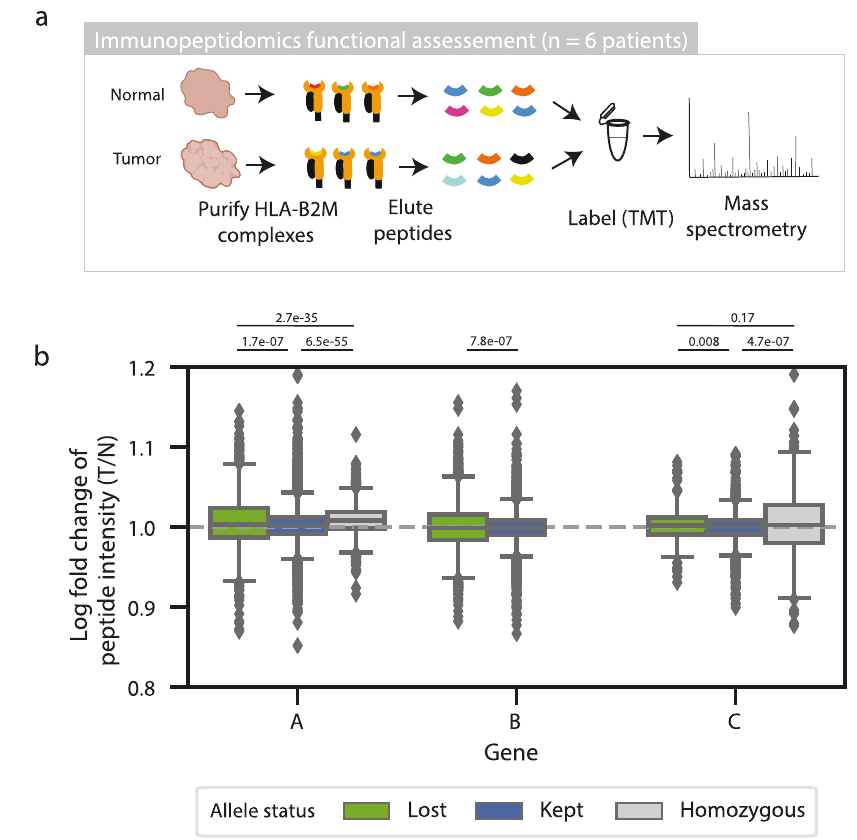
Fig. 4 Functional immunopeptidomic validation. a Functional immunopeptidomic validation was performed using paired tumor and adjacent normal fresh frozen samples. HLA- B2M complexes were puri fi ed from each sample and peptides were gently eluted. Peptides from each sample were labeled with TMT tags and measured using quantitative mass spectrometry. b Box plots showing the log2 fold change of peptide intensity between lost, kept, and homozygous alleles across all six patients. HLA-A is represented by 1490 peptides in the ‘ lost ’ category, 6613 peptides in the ‘ kept ’ category, and 2814 peptides in the ‘ homozygous ’ category. HLA-B is represented by 3823 peptides in the ‘ lost ’ category and 9910 peptides in the ‘ kept ’ category. HLA-C is represented by 703 peptides in the ‘ lost ’ category, 3421 peptides in the ‘ kept ’ category and 620 peptides in the ‘ homozygous ’ category. The center of the box denotes the median value, the box denotes the quartiles and the whiskers denote the remainder of the distribution apart from outliers. Statistical signi fi cance was assessed using a two-sided student T -test with asterisks denoting p -values < 0.05. Source data are provided with this